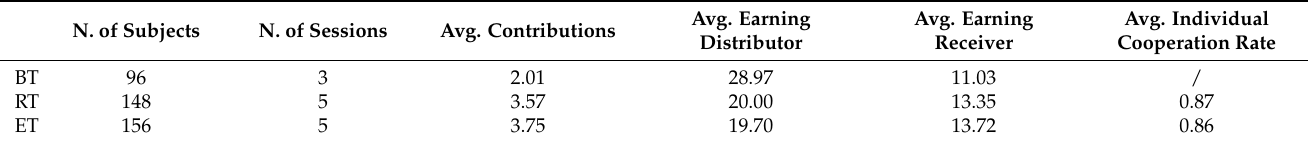
Table 1. Summary of the data.